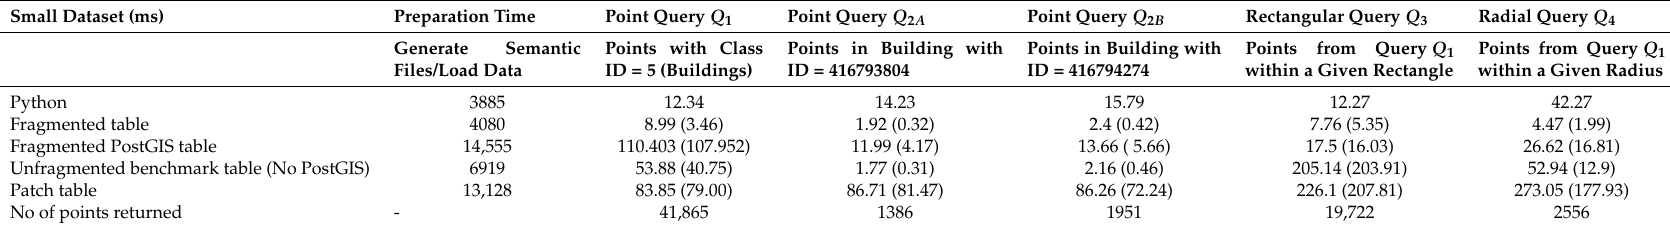
Table 4. The data loading times along with the query times for five queries using the SMALL dataset. For the database implementation the query times for hot queries are shown in parenthesis. All times are in milliseconds.